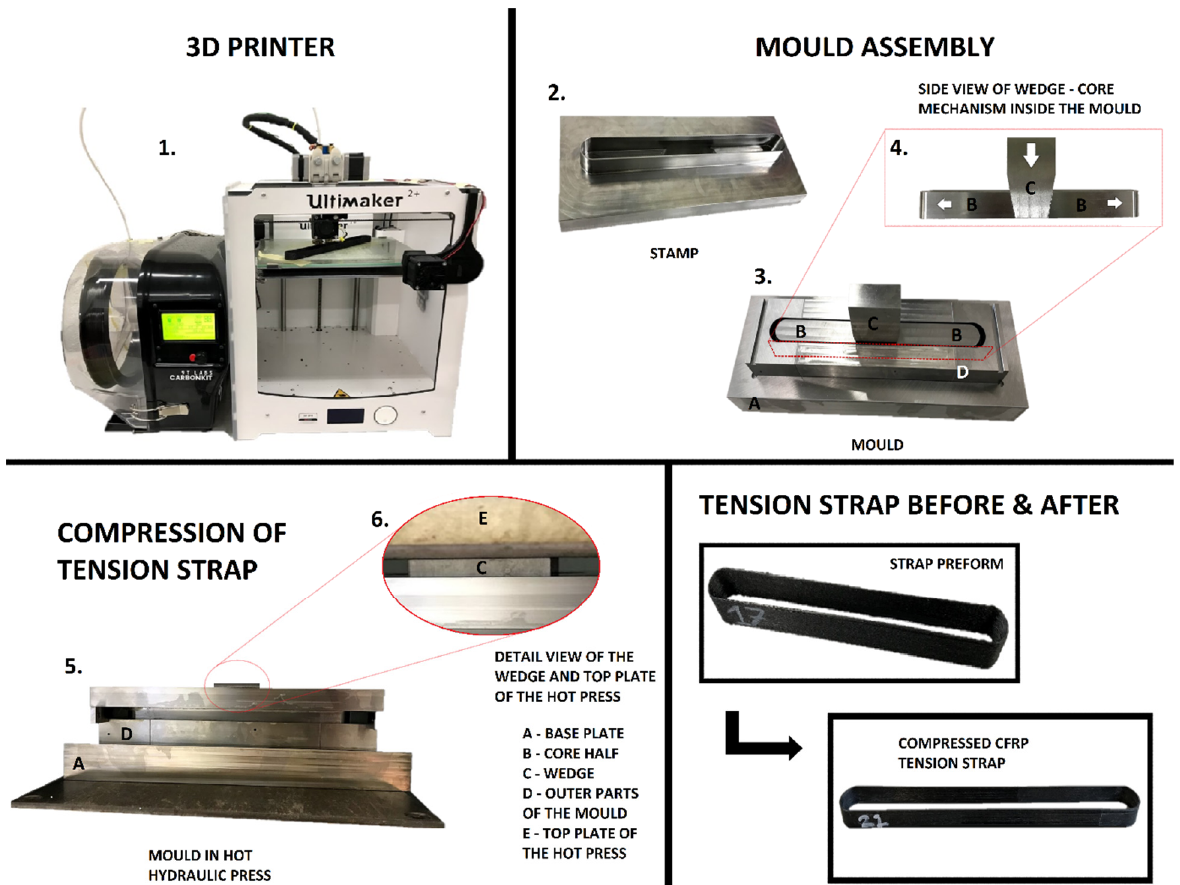
Figure 6. Manufacturing steps of 3D-printed CFRP straps with detailed mould assembly.